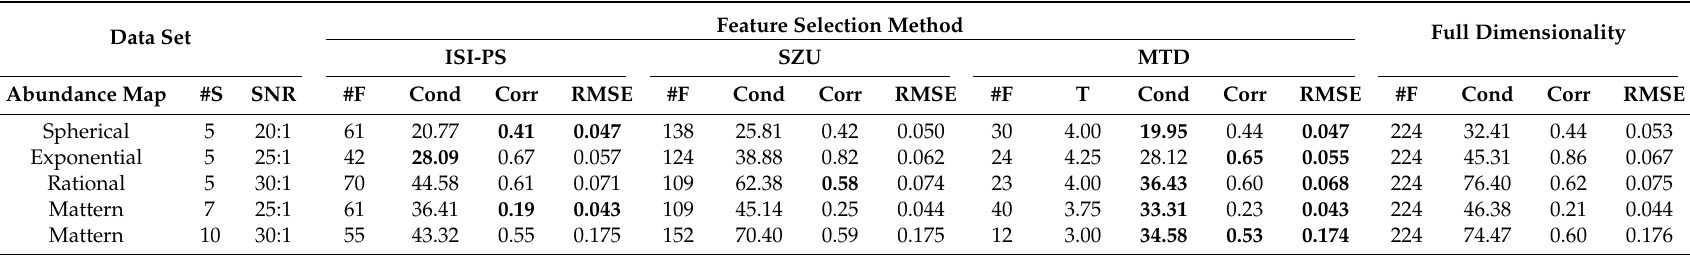
Table 3. The accuracy assessment results of the selected bands by MTD, SZU, and the proposed ISI-PS algorithms, in comparison with using all bands to estimate the fractional abundances through an unsupervised spectral unmixing on to the simulated